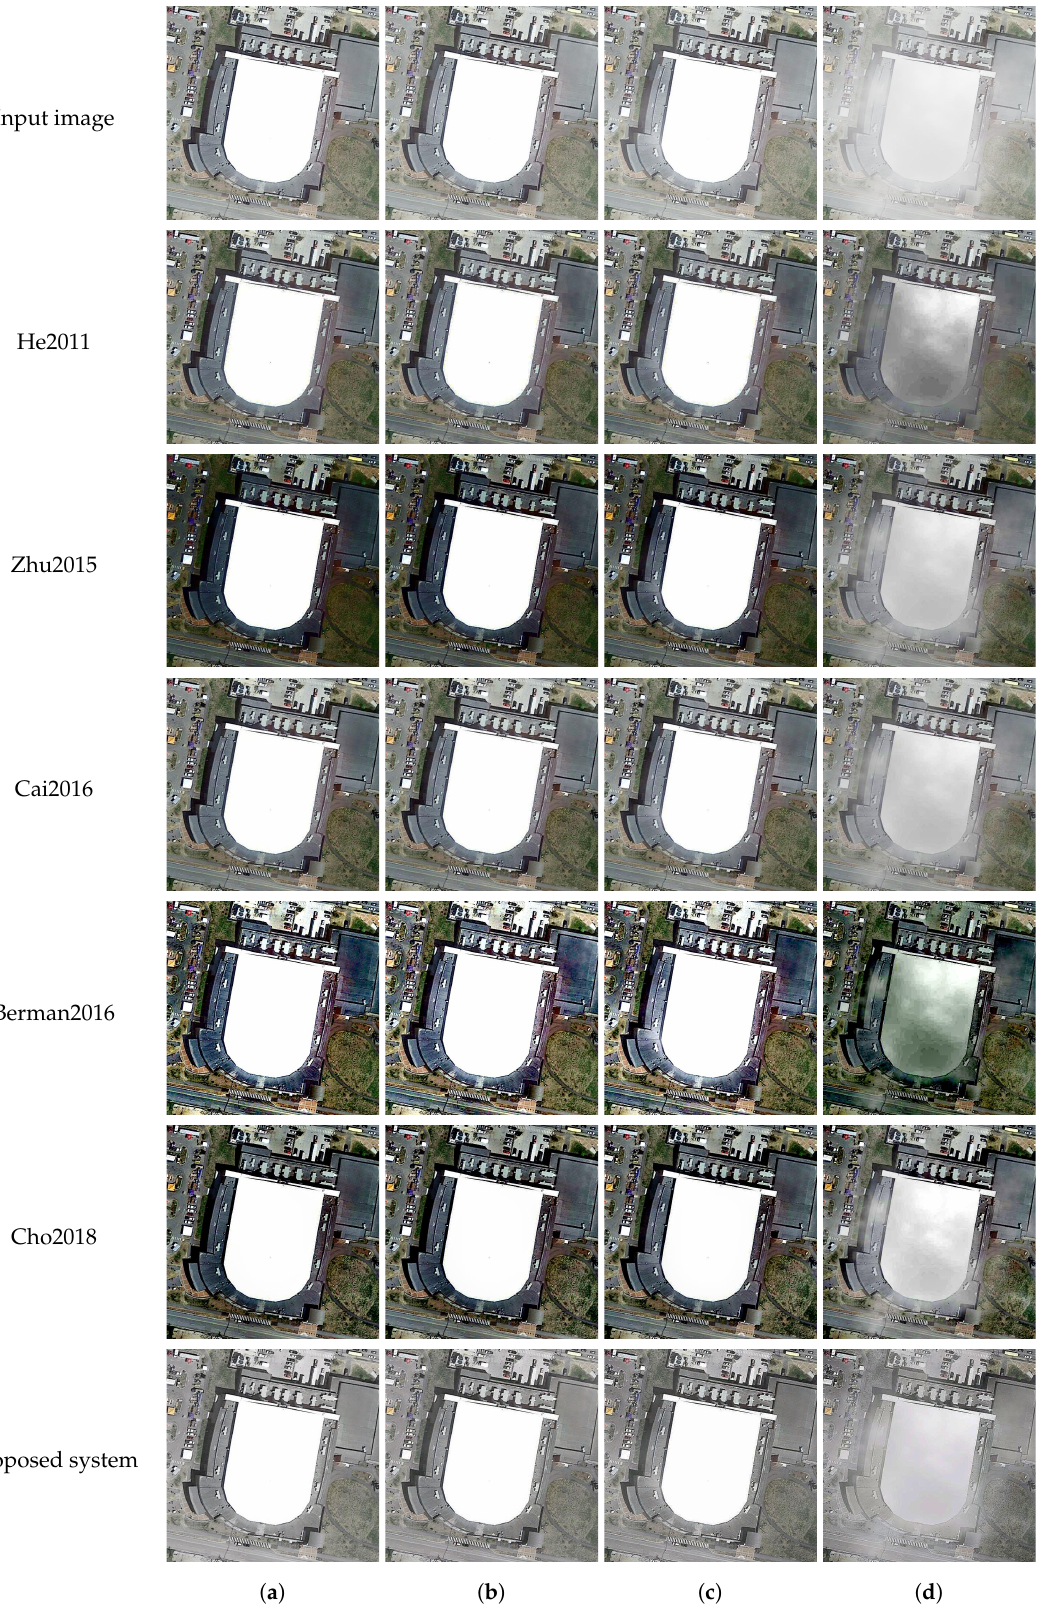
Figure 10. Qualitative evaluation of different image dehazing methods on an aerial image depicting a city center. ( a – d ) correspond to four haze conditions: haze-free, thin, moderate, and dense. The ρ I values of input images are 0.8581, 0.8974, 0.9135, and 0.9556, respectively. He2011, Zhu2015, Cai2016, Berman2016, and Cho2018 denote five benchmark methods of He et al. [9], Zhu et al. [11], Cai et al. [13], Berman et al. [12], and Cho et al.